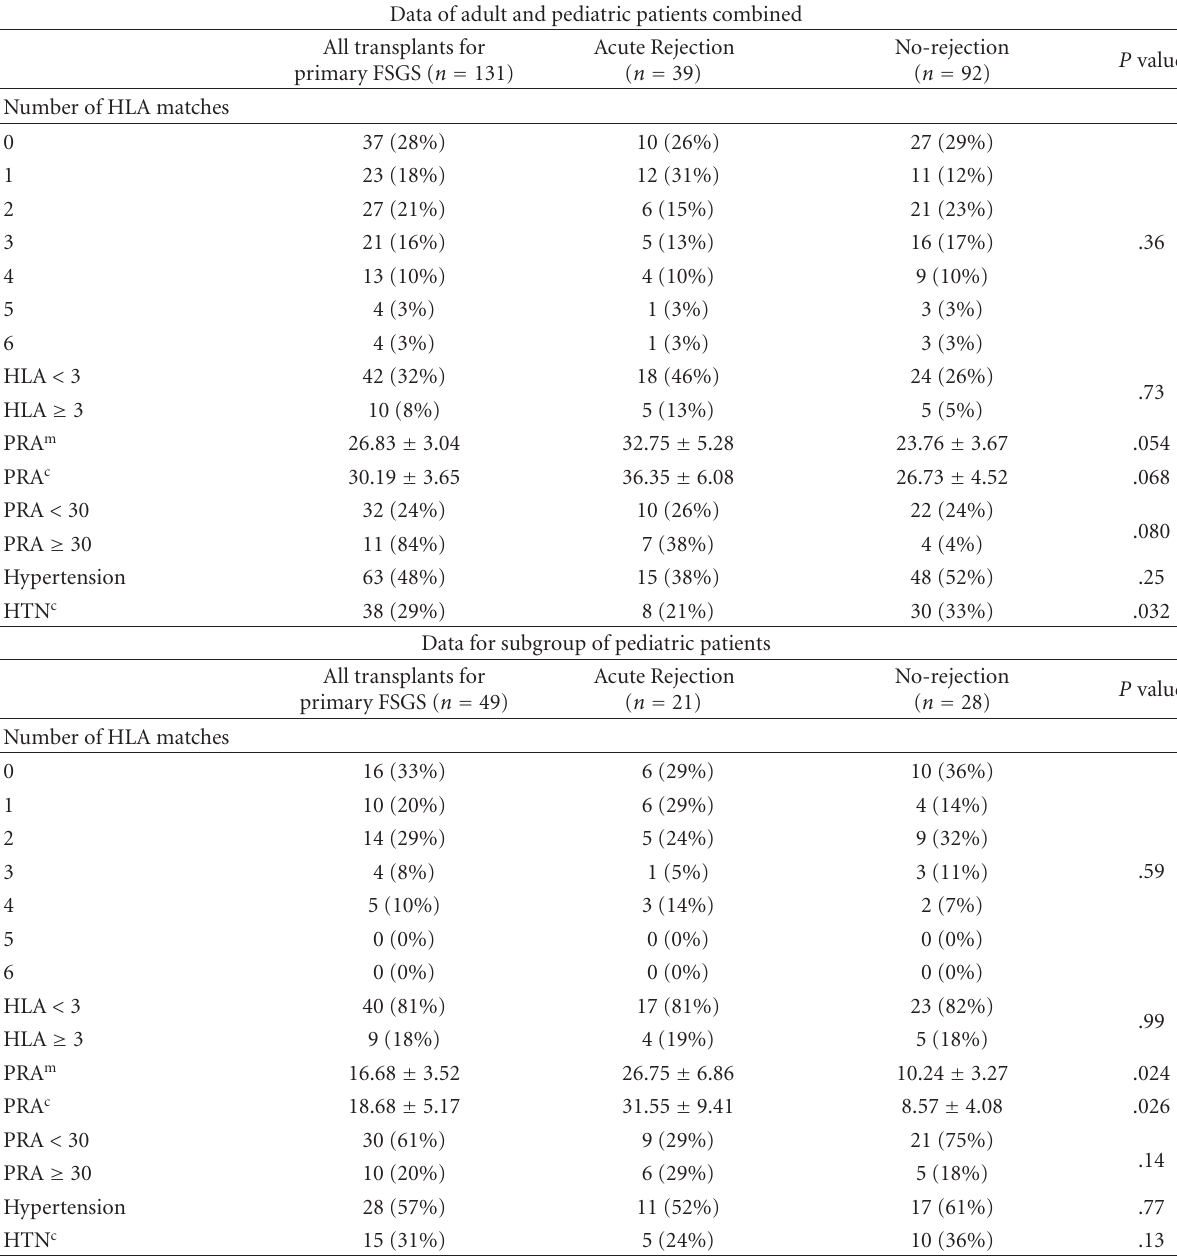
Table 4: (a) Acute Rejection in renal allograft recipients from 1990 to 2007 at Montefiore Medical Center. (b) Subgroup of subjects with acute rejection adjusted for FSGS recurrence in renal allograft recipients from 1990 to 2007 at Montefiore Medical